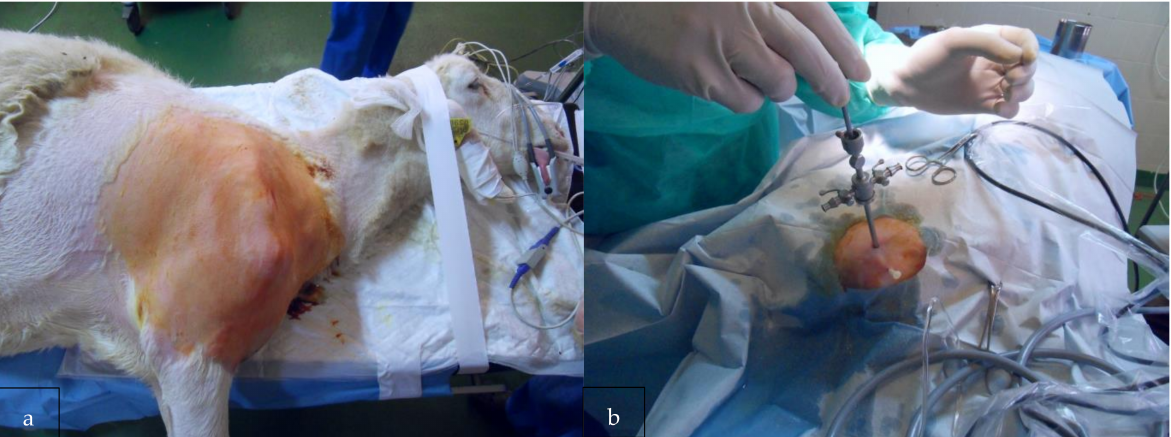
Figure 1. ( a ) Shoulder arthroscopy was performed in the lateral decubitus with standard portals. ( b ) Standard portals were performed (posterior and antero-lateral).